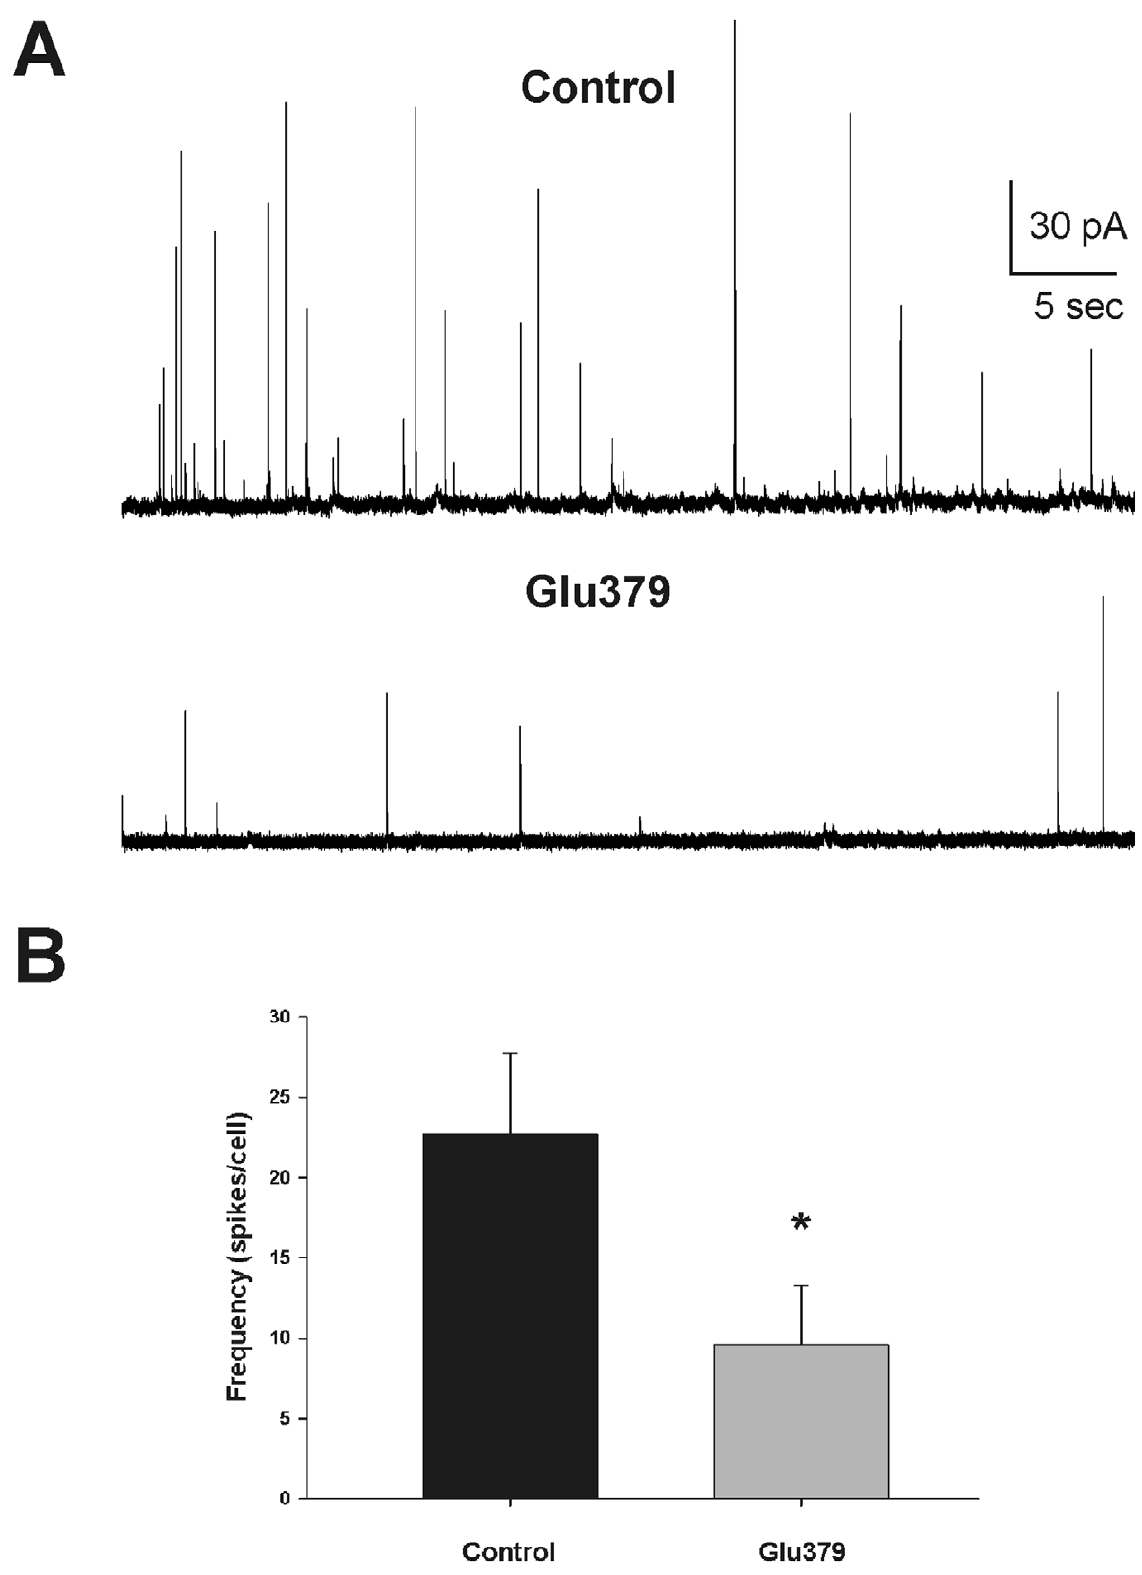
Figure 3. The Munc18-1 Glu379 insertion mutation reduces frequency of exocytosis. (A) Amperometric trace examples from bovine adrenal chromaffin cells expressing the Munc18-1 Glu379 insertion mutant (Glu379) or from untransfected cells (Control). (B) Frequency of individual fusion events was significantly reduced in Glu379 expressing cells in response to stimulation (*; p , 0.01). Data were analysed from 431 spikes from 19 responding cells (control) and 67 spikes from 7 responding cells (Glu379). Note that the vast majority of Glu379 cells did not respond to stimulation at all.